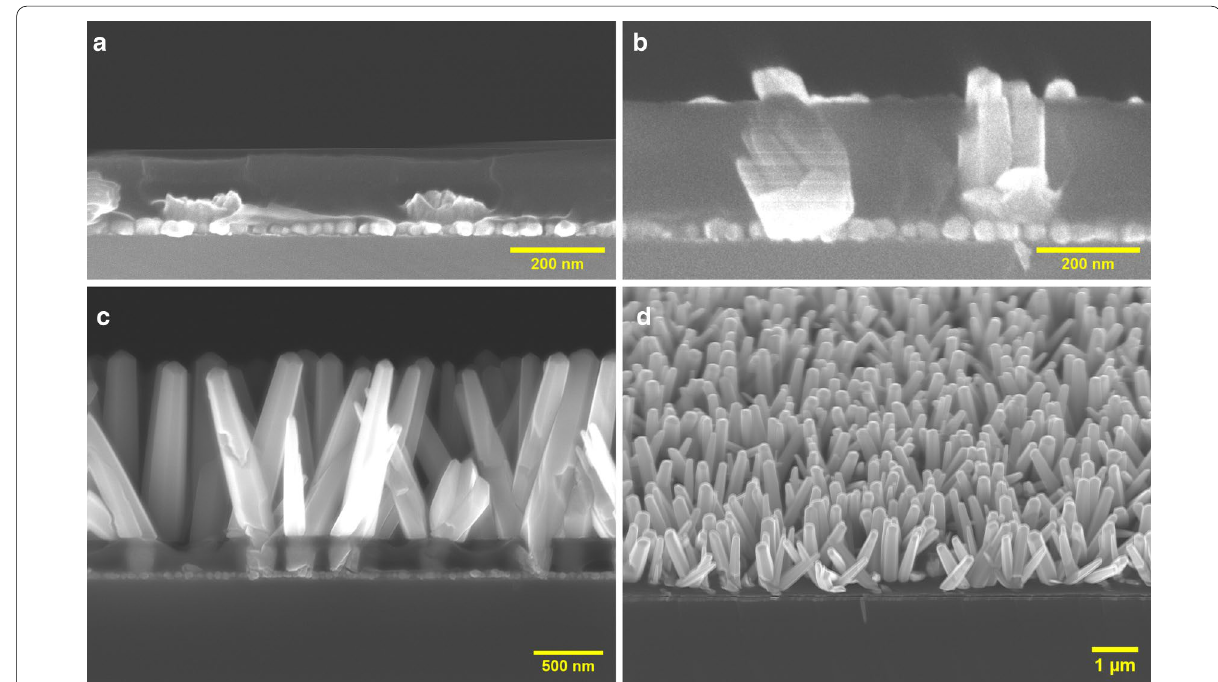
Fig. 5 Cross-sectional SEM images of CBD-grown ZnO NRs on CL-patterned ZnO NP seed layers on (100) Si substrates after a growth time of a 5 min, b 25 min, c 2 h and d 2 h at 45°